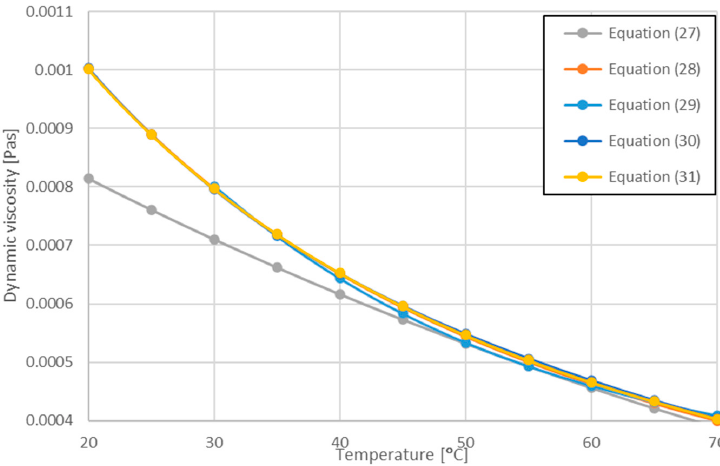
Figure 3. Viscosity of water.